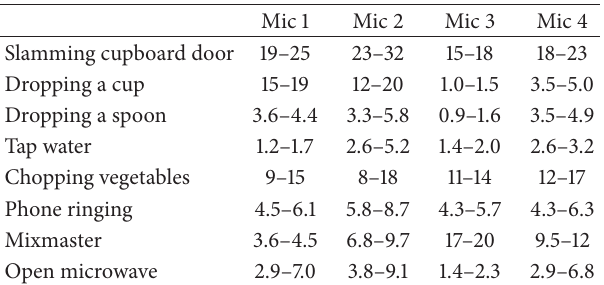
Table 1: Estimated SNR ranges (dB) for the noisy sounds of daily life database, comprising various sounds recorded in the presence of radio noise (two volume levels), speech noise, and rain